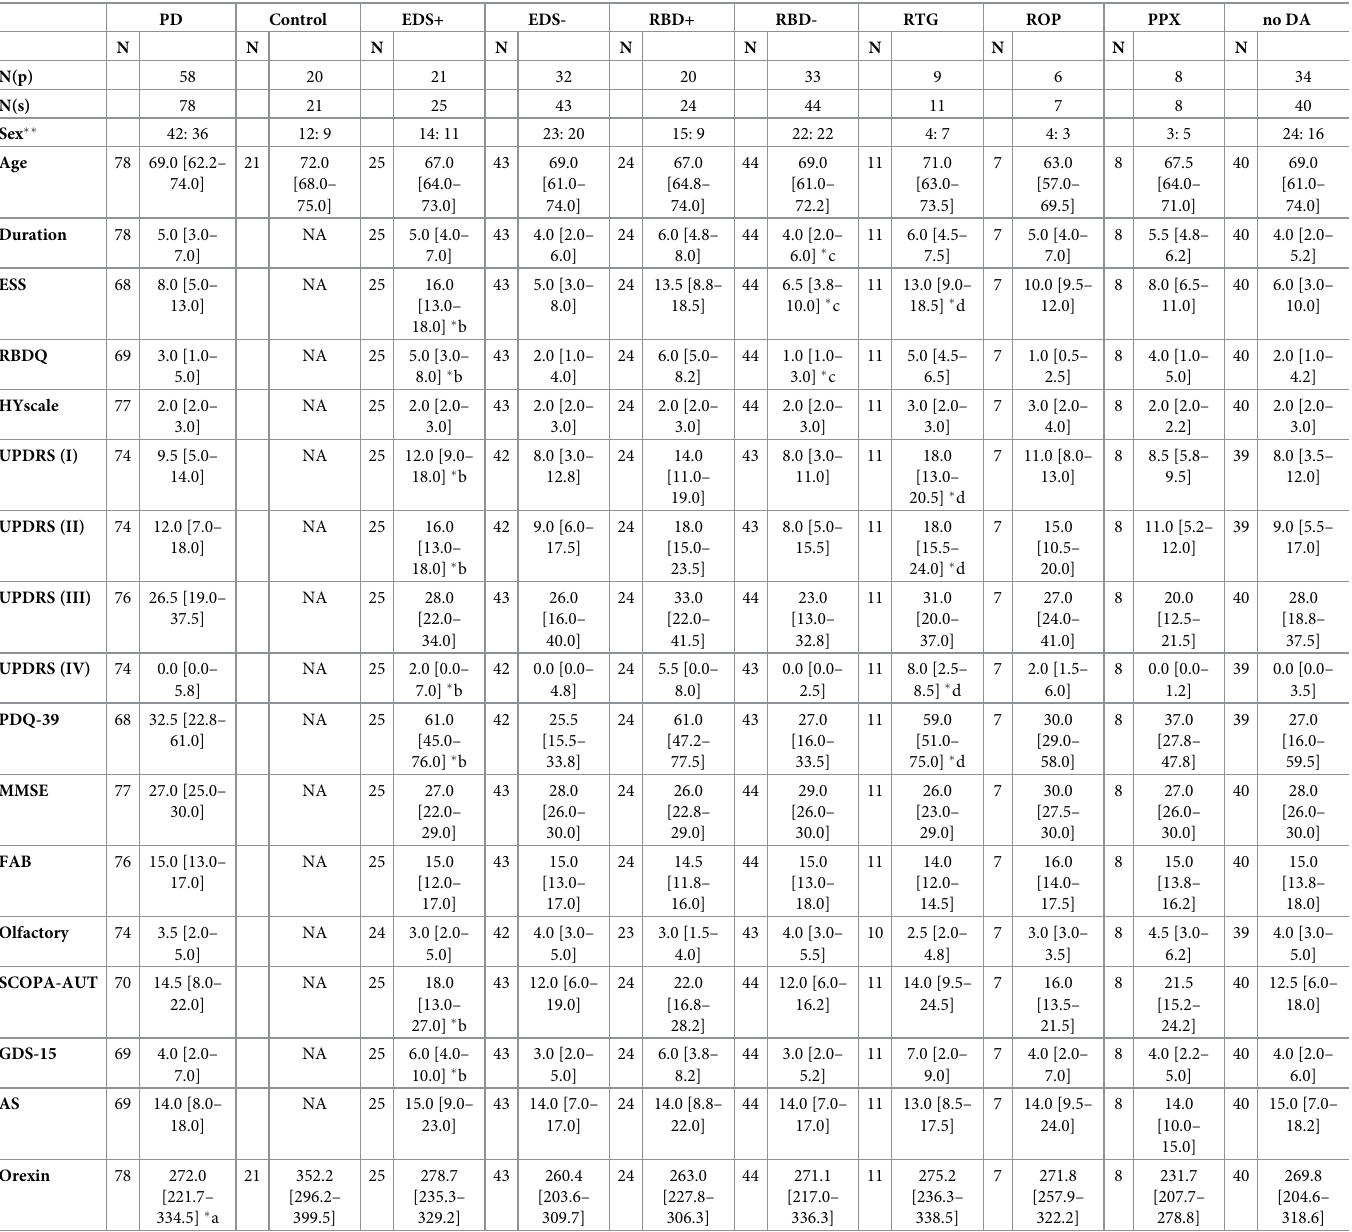
Table 1. Characteristics of participants �